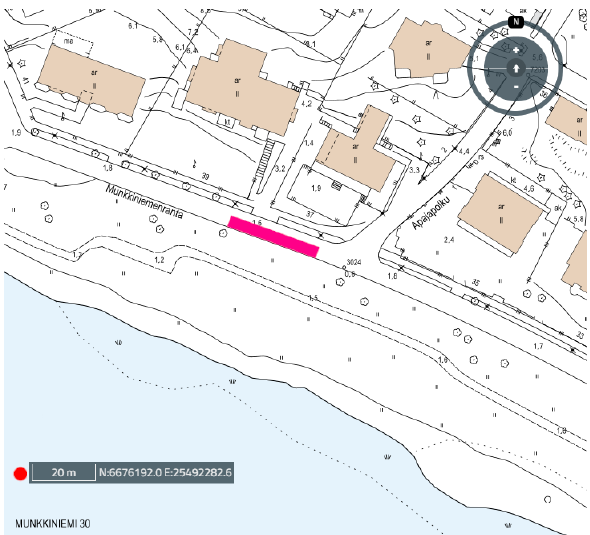
Figure 2. The measurement location in Munkkiniemenranta. The magenta area indicates the area of